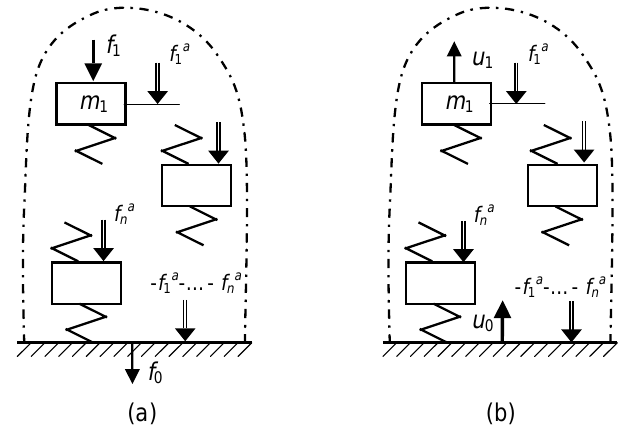
Fig. 5. Generic multi-degree-of-freedom elastic-inertial active vibration isolation system. (a) Force excitation. (b) Kinematic excitation.